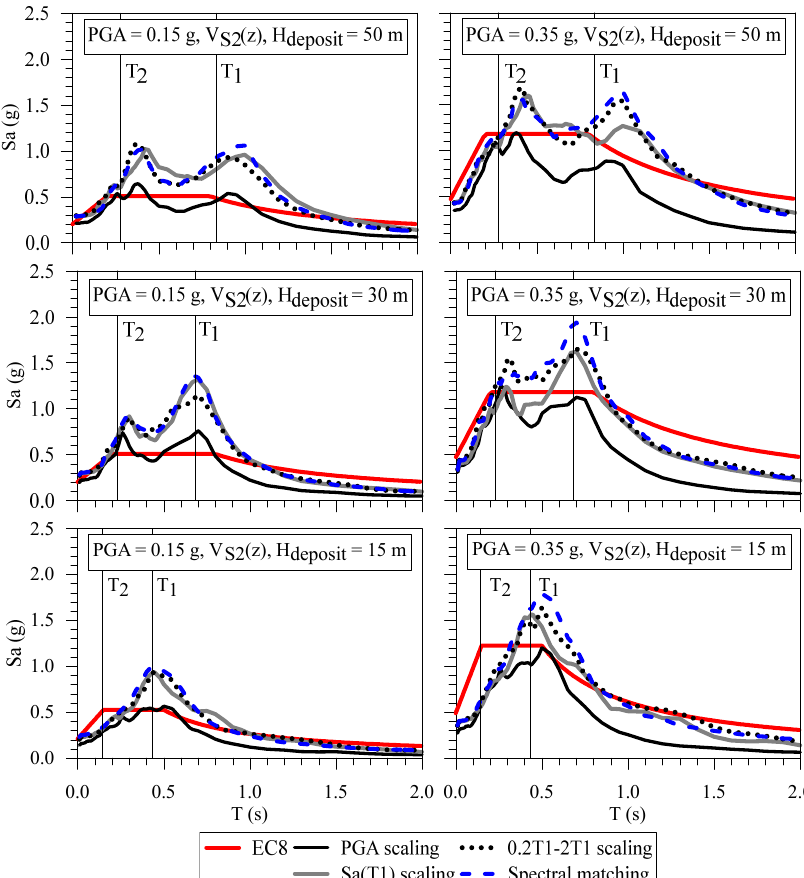
Figure 6. Mean response spectra of the ground surface motions obtained by means of LSSR analyses considering the V S2 (z) profile, 4 different selection strategies, and PGA equal to 0.15 g and 0.35 g. The EC8 response spectra going from the first to the bottom line refer to ground type D, D, and E, respectively.